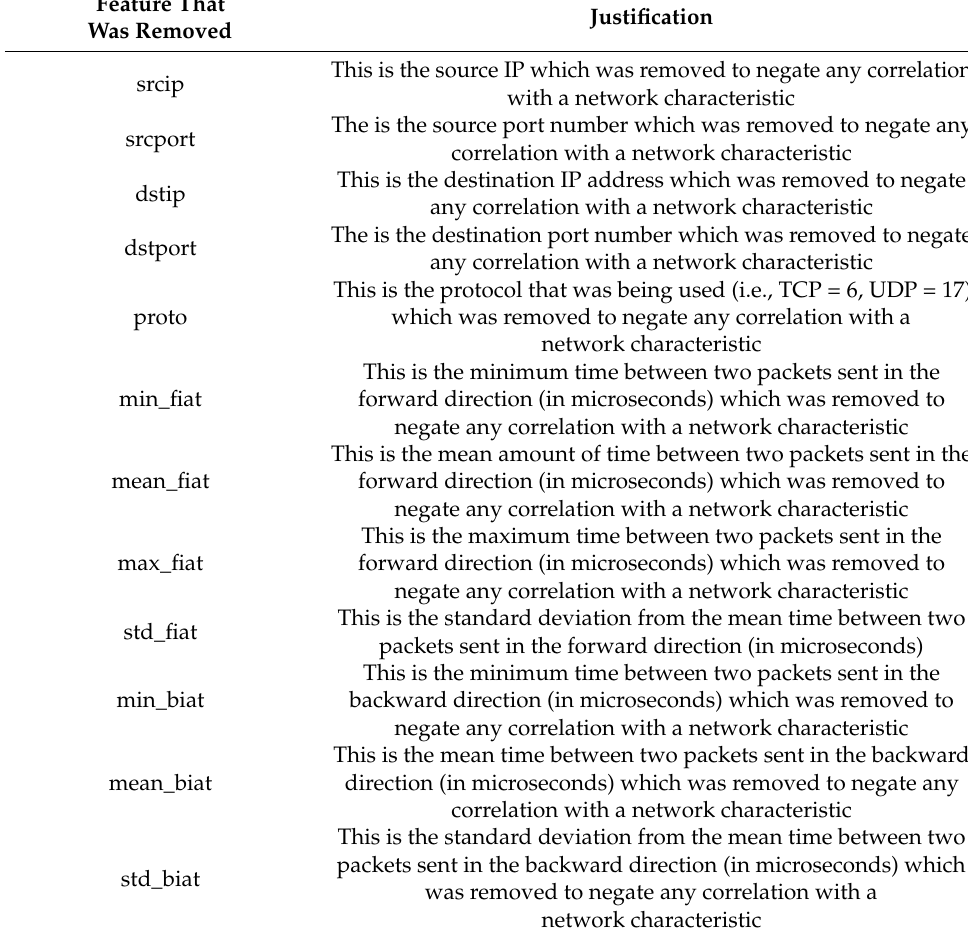
Table 1. The features that were not used during this